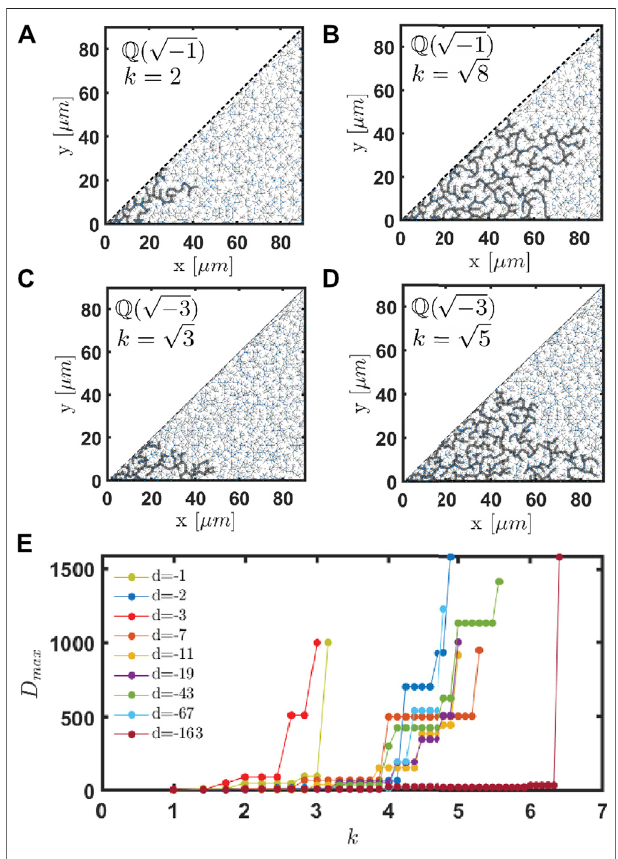
FIGURE 5 | Minimum spanning tree analysis applied to the Gaussian prime array when the maximum allowed edge length k (also named moat (cid:1)(cid:1) √ value) is equal to 2 panel (A) and 8 panel (B) . Panels (C) and (D) show the samestudyperformedontheEisensteincon fi gurationwhen k isequalto (cid:1)(cid:1) √ (cid:1)(cid:1) √ 3 (panel c) and 5 (panel d). Panel (E) compares the maximum distance D max ,evaluated formtheorigin ofeach structures,ofall theinvestigated CPAs for given moat values k .